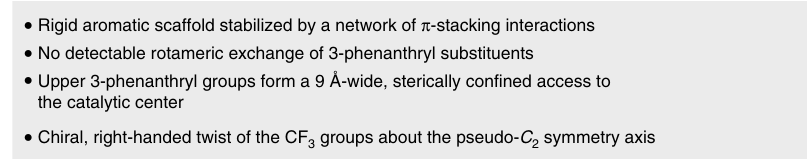
Fig. 4 The solution structure of catalyst 4g . Structural characteristics of our catalysts were revealed by using NMR-based models